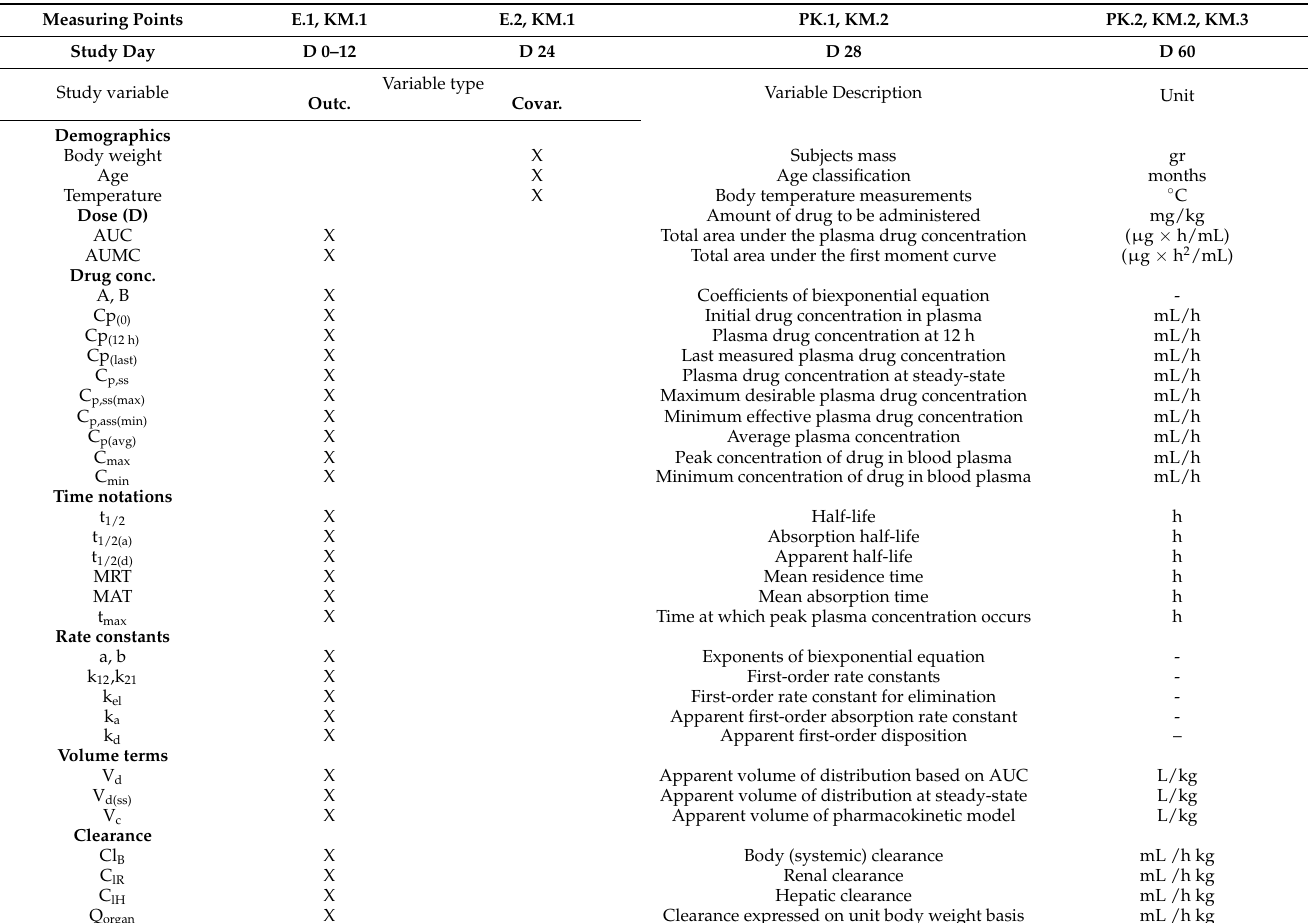
Table 4. Study parameters and relevant data will be collected and monitored by the investigator team assessing the PK/PD effects. The following table provides an overview of the planned PK variables and their corresponding calculation